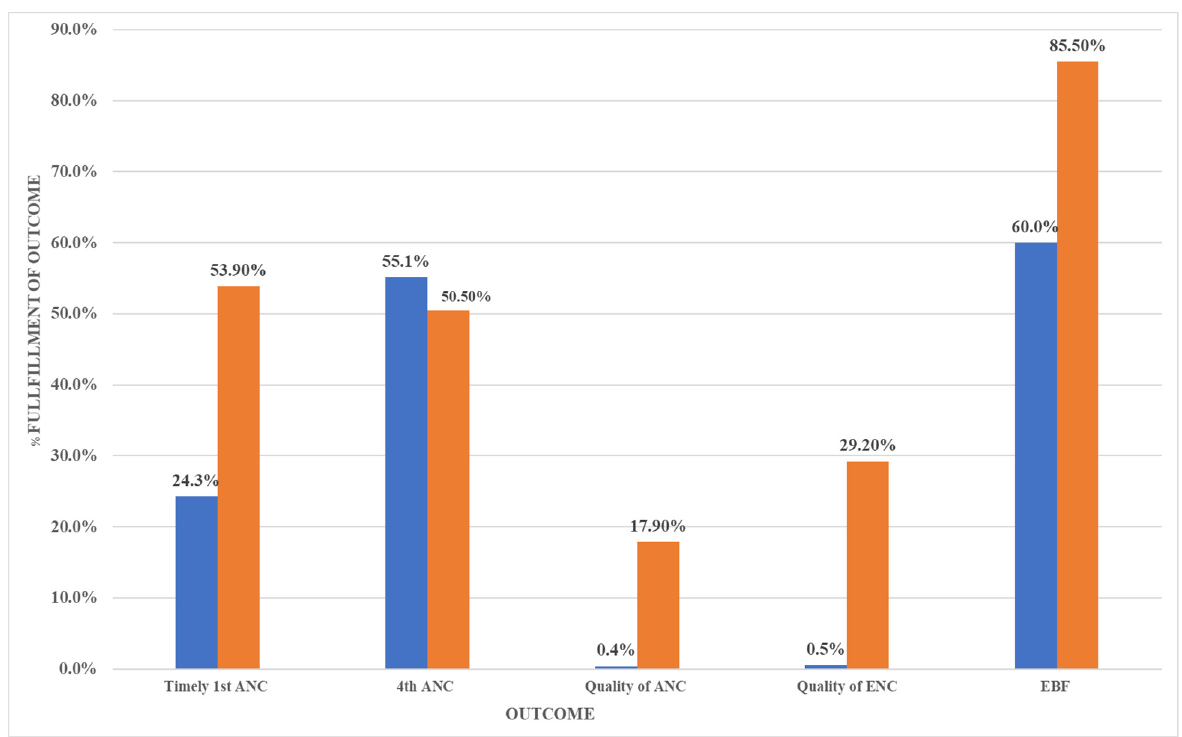
Figure 1. Change in key outcome variables. = baseline values; = post-implementation values; ANC = Antenatal care; ENC = Essential Newborn care; EBF = Exclusive Breastfeeding.